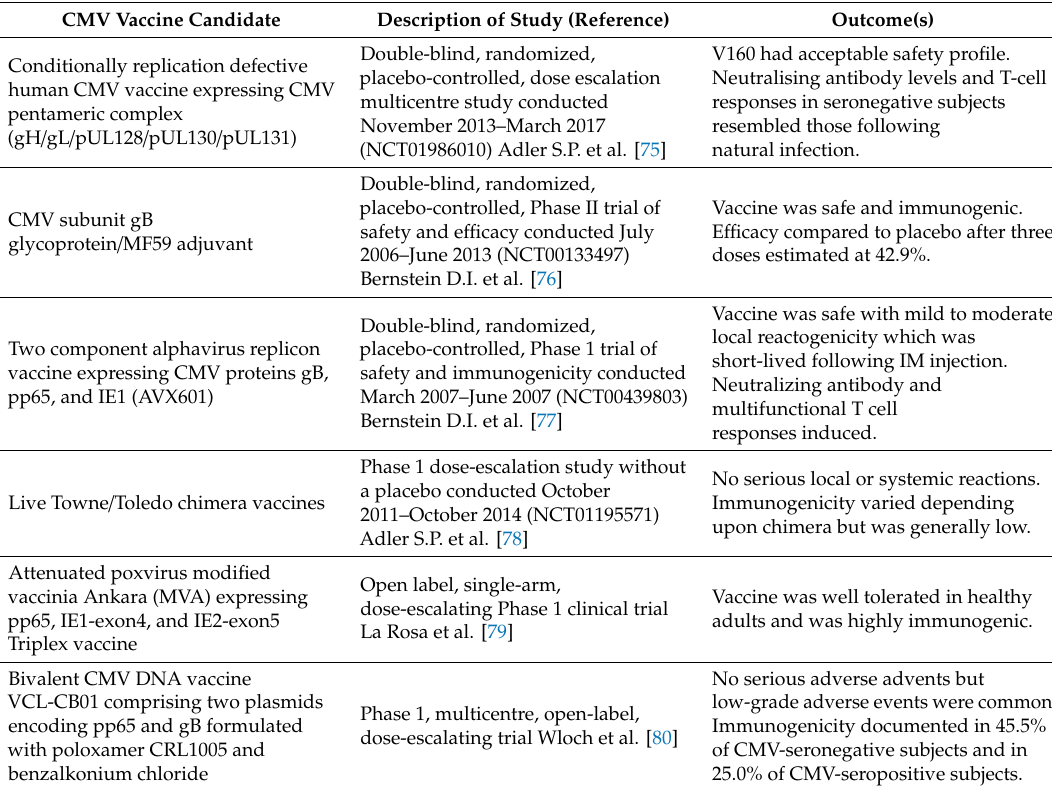
Table 1. Reported clinical trials of several vaccine candidates with potential for the prevention of congenital cytomegalovirus